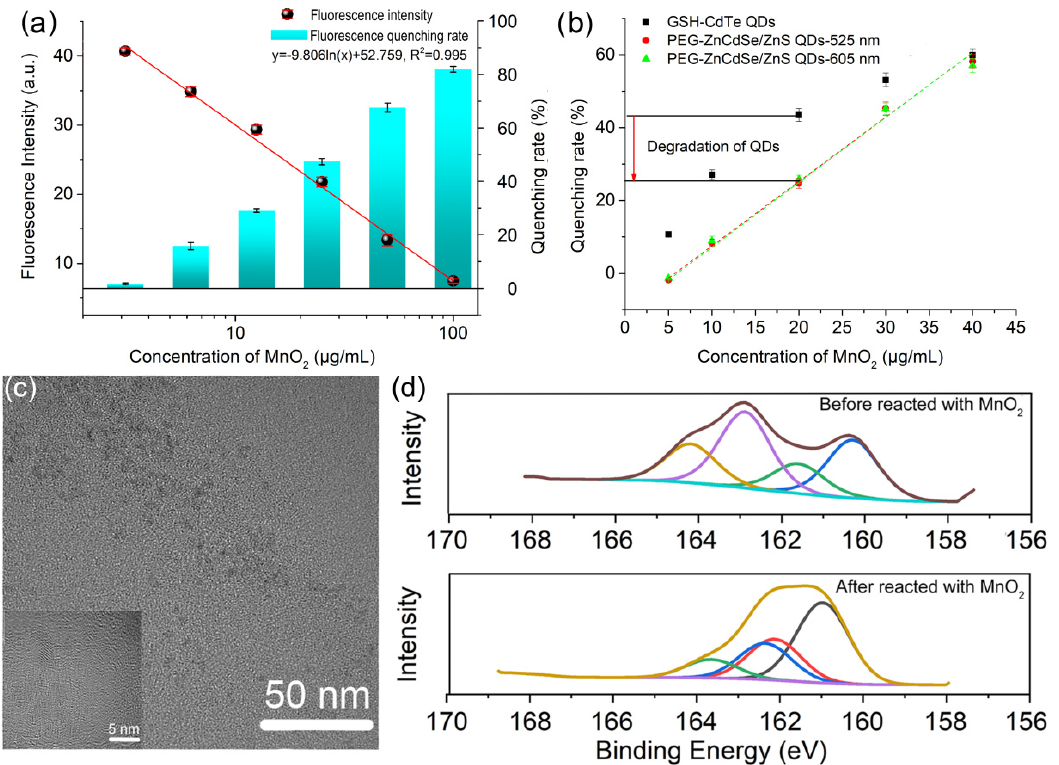
Figure 4. Verification of MnO 2 NSs/GSH-QDs quenching system. Fluorescence intensity and quenching rate of GSH-CdTe QDs after reaction with different concentrations of MnO 2 NSs ( a ); Comparison of the quenching ability of MnO 2 NSs to deferent QDs ( b ); TEM images and HR-TEM images (Insert) of MnO 2 NSs/GSH-QDs system ( c ); and XPS of GSH-CdTe QDs (S 2p) before and after reacted with MnO 2 NSs ( d ).